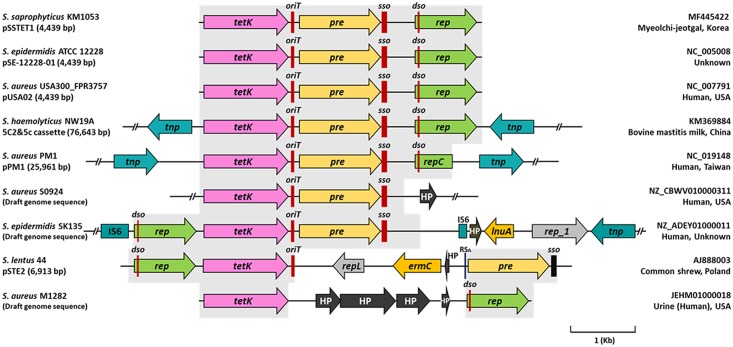
tetK genes and their flanking regions found in Staphylococcus species.Shaded boxed regions possess over 99% nucleotide sequence identity with pSSTET1. All sequences of dso, sso containing RSB, and oriT containing RSA identified in this study are indicated with red vertical lines. Abbreviations: oriT, origin of transfer; sso, single-stranded origin of replication; dso, double-stranded origin of replication; tetK, tetracycline resistance gene; lnuA, lincomycin resistance gene; ermC, erythromycin resistance gene; pre, plasmid recombination enzyme gene; rep, replication protein gene; repC, truncated replication protein gene; rep_1, replication protein gene; repL, plasmid replication protein gene; tnp, IS431 transposase gene; IS6, IS6 family transposase gene; and HP, hypothetical protein gene.